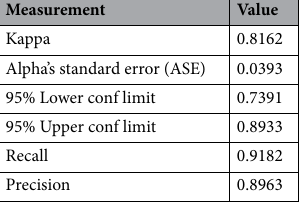
Table 10. Cohen’s kappa coefficient, recall and precision results for the multi-lameness classifiers.